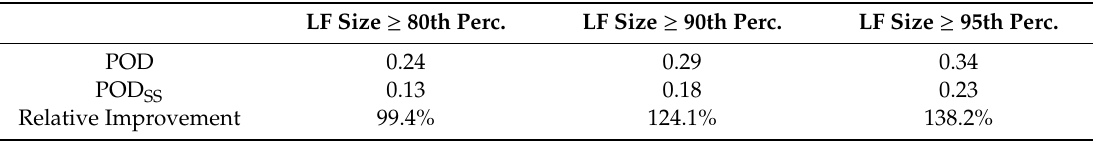
Table 3. Area-wide Probability of Detection (POD), POD skill scores, and POD relative improvement in Red Flag Warnings when large fire day (LFD) was defined at 80th, 90th, and 95th percentile fire size thresholds. LF Size ≥ 80th Perc.